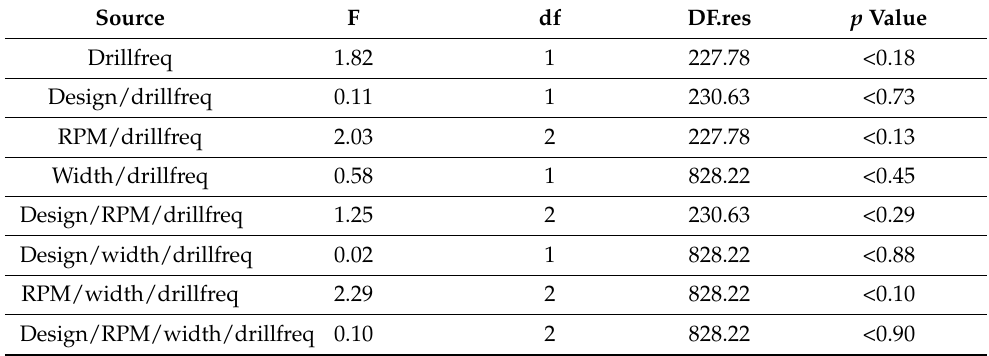
Table 2. Analysis of deviance table; one-, two-, three- and four-way interactions between the variables.